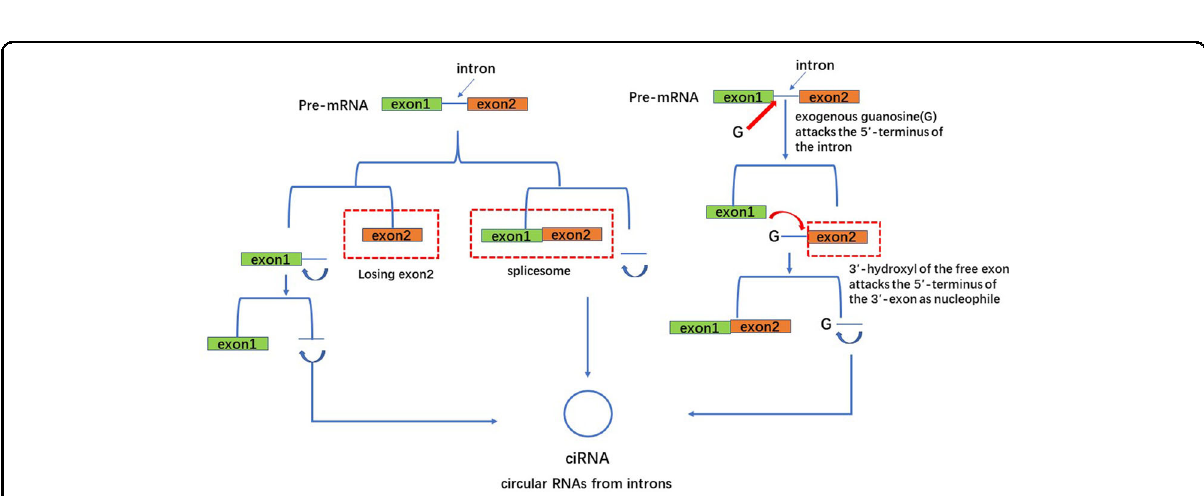
Fig. 3 During the formation of ciRNA, exons are removed and introns are cyclized to form ciRNA. 1. A pre-mRNA is spliced by a spliceosome, producing an RNA lariat circularized with 2 ′ ,5 ′ -phosphodiester. Finally, remove the 3 ′ - tail of the RNA lariat and then form ciRNA. 2. The precursor RNA loses the 3 ′ -exon. Then, the 2 ′ -hydroxyl of the 3 ′ -terminus attacks the 5 ′ -terminus of the intron, producing a ciRNA. 3. Exogenous guanosine (G) attacks the 5 ′ -terminus of the intron as nucleophile, causing the 5 ′ -exon to be cut off. Then, the 3 ′ - hydroxyl of the free exon acts as a nucleophile to attack the 5 ′ -terminus of the 3 ′ -exon, generating a linear intron. The linear introns then form a circularized RNA lariat, and fi nally